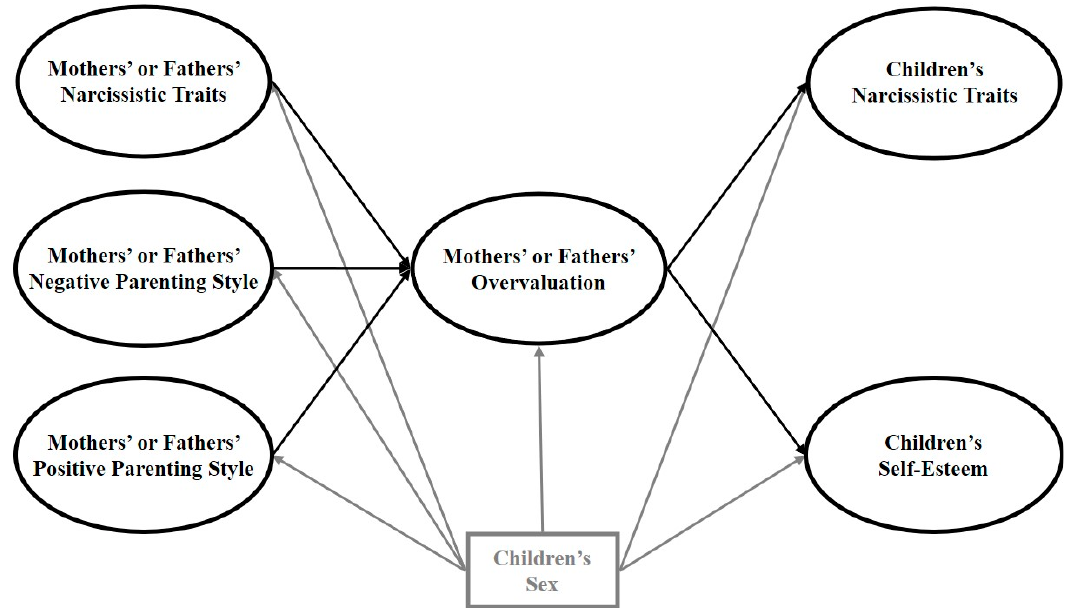
Figure 1. Theoretical full mediation model of the relations of parental narcissism, positive parenting, and negative parenting with children’s narcissism and self-esteem via parental overvaluation. The key study variables and their related paths are presented in black. As the control variable, sex and its related paths are presented in gray.